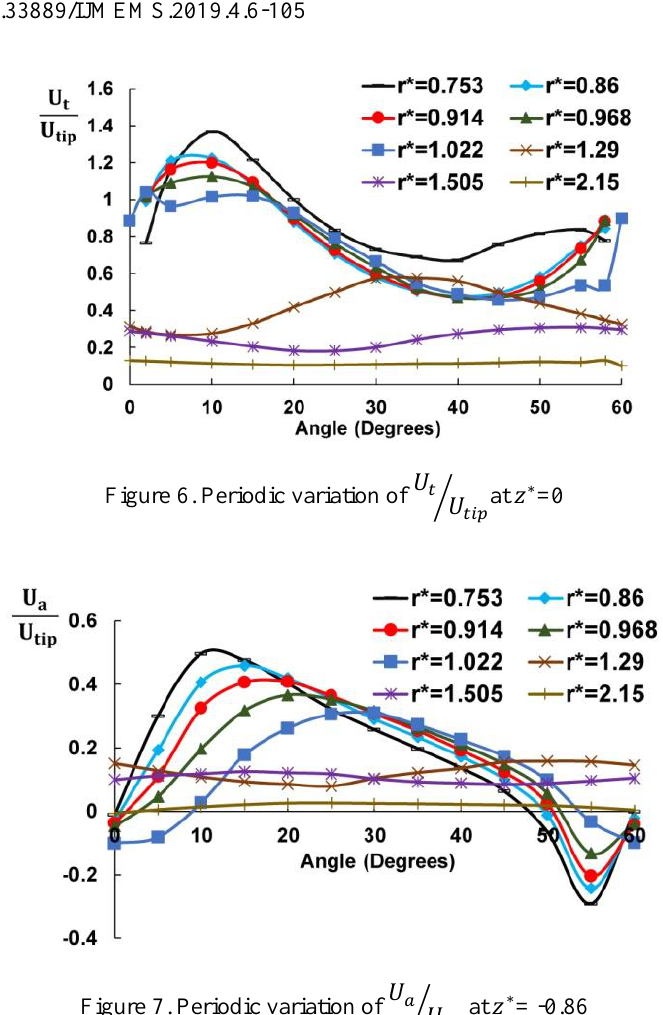
Figure 7. Periodic variation of